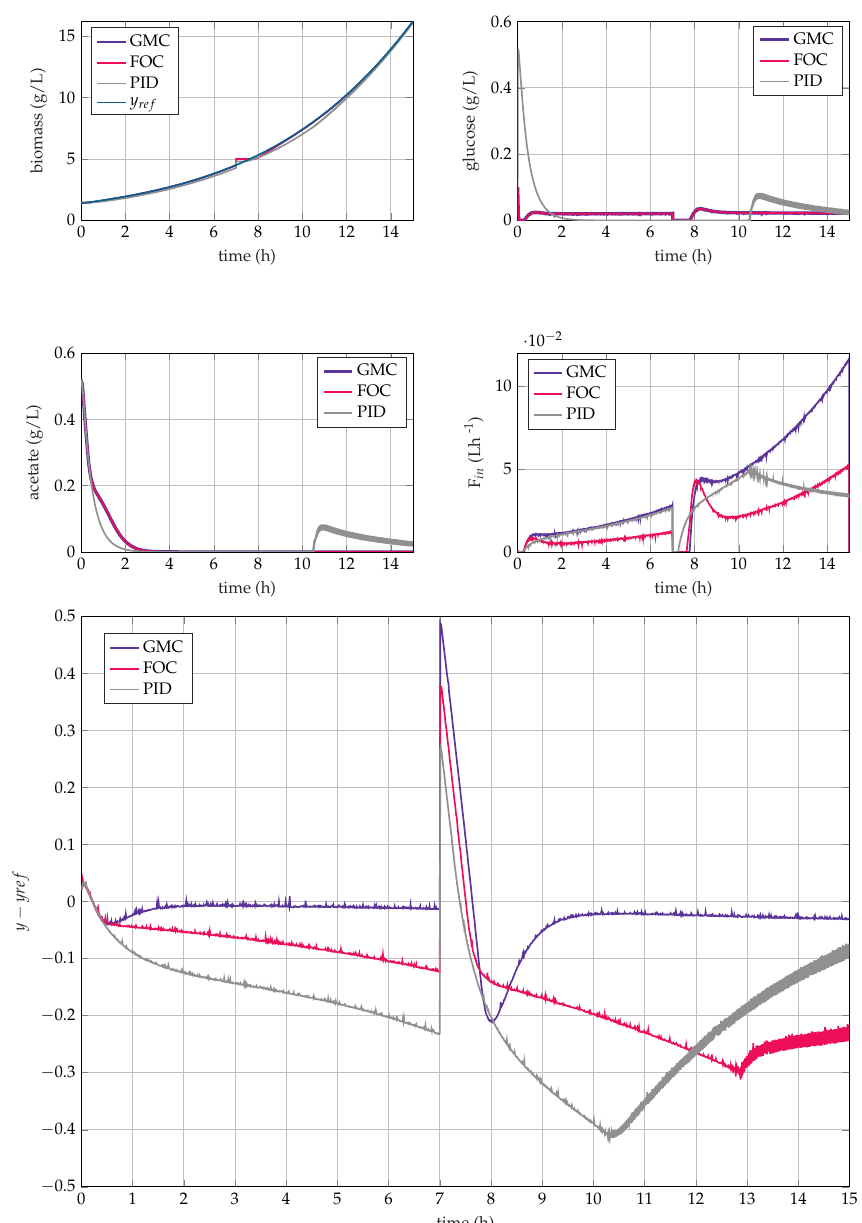
Figure 12. Comparison of the GMC performance with a first-order controller (FOC) and a PID